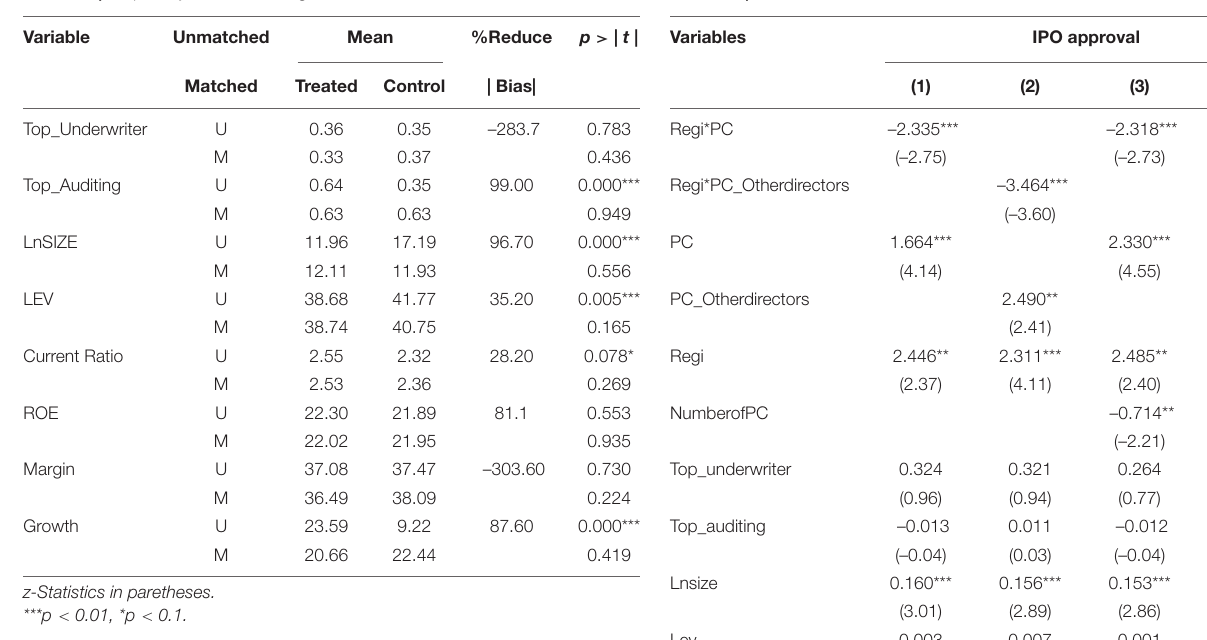
TABLE 7 | Propensity score matching result. TABLE 8 | PSM-DID for robustness